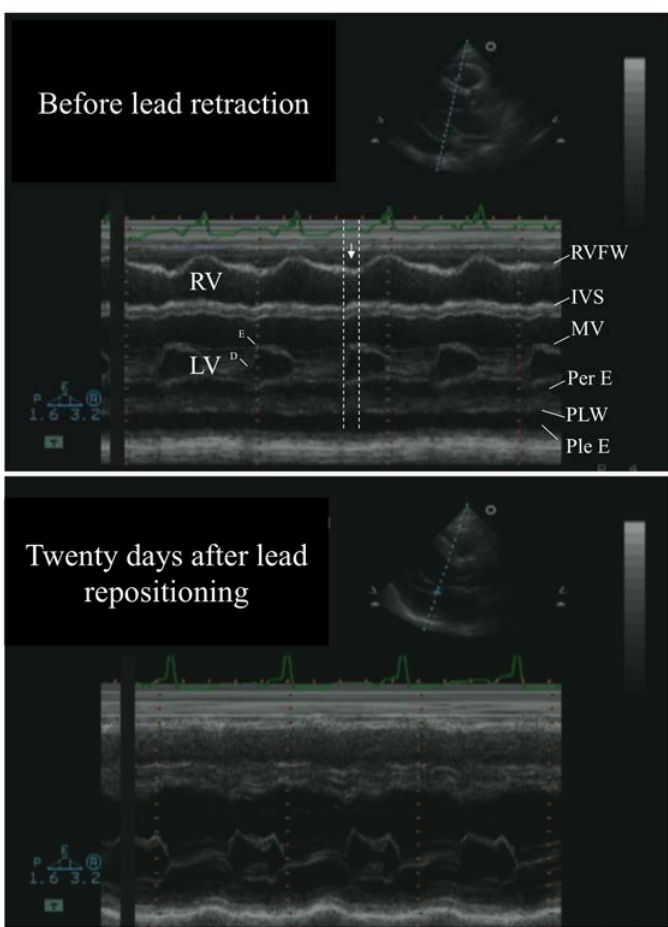
Figure 1. Pericardial effusion time course by transthoracic echocardiography. The upper part of the figure illustrates an m ‐ mode at the mitral valve level before lead repositioning. The pericardial effusion (Per E) is evident, revealing a moderate ‐ severe amount (>2 cm separation of the pericardial layers, that appears even larger toward the apex, as evident in the 2 ‐ D guiding image at the top of the screen); there is also sign of tamponade, revealed by the protodiastolic collapse of the free wall of the right ventricle (inward motion, identified by the vertical arrows), as it occurs during mitral valve opening (D – E slope) (the vertical dashed lines define the protodiastolic phase). The lower part of the figure is the same view 24 days after the lead repositioning. The pericardial effusion is totally gone. RV= right ventricle; LV= left ventricle; RVFW= right ventricle free wall; IVS= inter ‐ ventricular septum; MV= mitral valve; Per E= pericardial effusion; PLW= posterior wall of left ventricle; Ple E= pleural effusion.